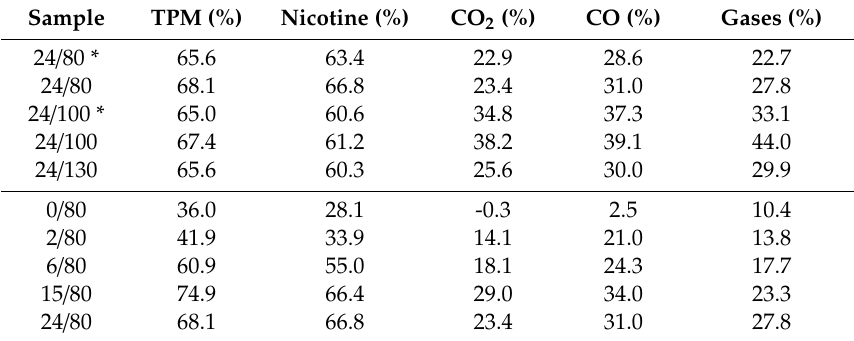
Table 2. Reduction expressed in % of total particulate matter (TPM), nicotine, CO 2 , CO, and gases from smoking experiments to study the e ff ect of the variables on hydrothermal treatment.